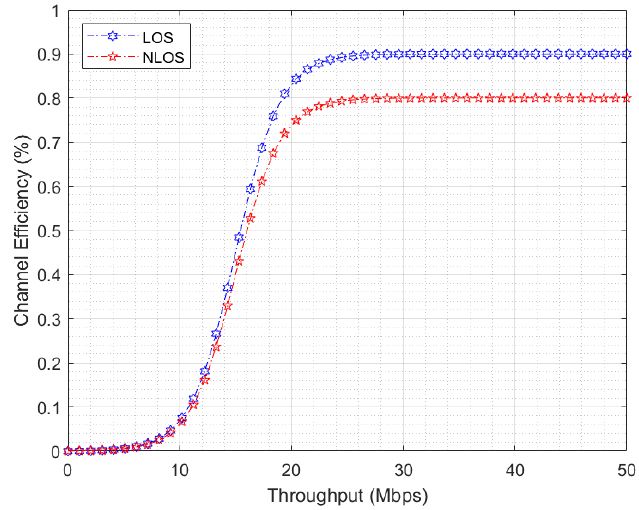
Figure 14. Channel efficiency vs throughput of the network with OAA.